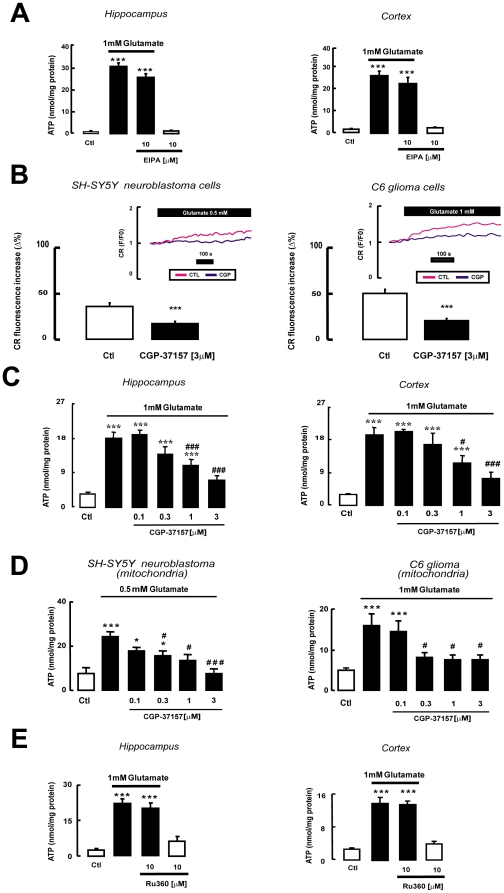
NCX dependence of glutamate-stimulated ATP synthesis.(A) The NHE blocker EIPA (10 µM) was not able to affect baseline (white bars) and glutamate-stimulated (black bars) ATP synthesis in mitochondria isolated from rat hippocampus or cortex. (B) The bar graphs illustrate the glutamate-dependent Na+
mit response in SH-SY5Y and C6 cells in the control condition and after 20 min exposure to CGP-37157 (3 µM). Na+
mit response to the glutamate challenge was measured as the percent increase from resting Na+
mit (Δ%), i.e. from the mean Na+
mit recorded during the 120 s preceding the challenge to the highest Na+
mit value reached after glutamate stimulation. The insets report representative records of glutamate induced Na+
mit response obtained in SH-SY5Y and C6 cells, under control condition (pink line) and after CGP-37157 treatment (blue line). Each bar represent the mean ± SEM of 48–58 cells recorded in 3 different experimental sessions. *** p<0.001 vs control. (C) Effects of rising concentrations of the mitochondrial NCX blocker CGP-37157 on glutamate-stimulated ATP synthesis in mitochondria from rat hippocampus or cortex; similar results were obtained in mitochondria isolated from SH-SY5Y and C6 cells (D). (E) The Ca2+ uniporter inhibitor Ru360 (10 µM) was not able to affect baseline (white bars) and glutamate-stimulated (black bars) ATP synthesis in mitochondria isolated from rat hippocampus or cortex. Each bar represents the mean ± SEM of 10 different determinations. * p<0.05 vs control; *** p<0.001 vs control; # p<0.05 vs 0.5 or 1 mM glutamate; ### p<0.001 vs 0.5 or 1 mM glutamate.